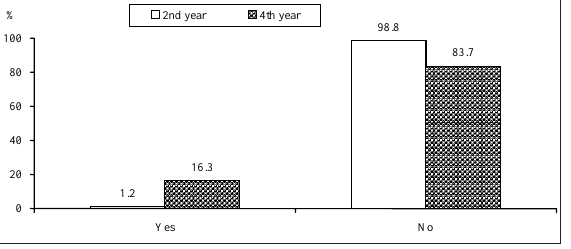
Fig. 2. Results of answers to the question “Are you working in the sphere of tourism and sport?”